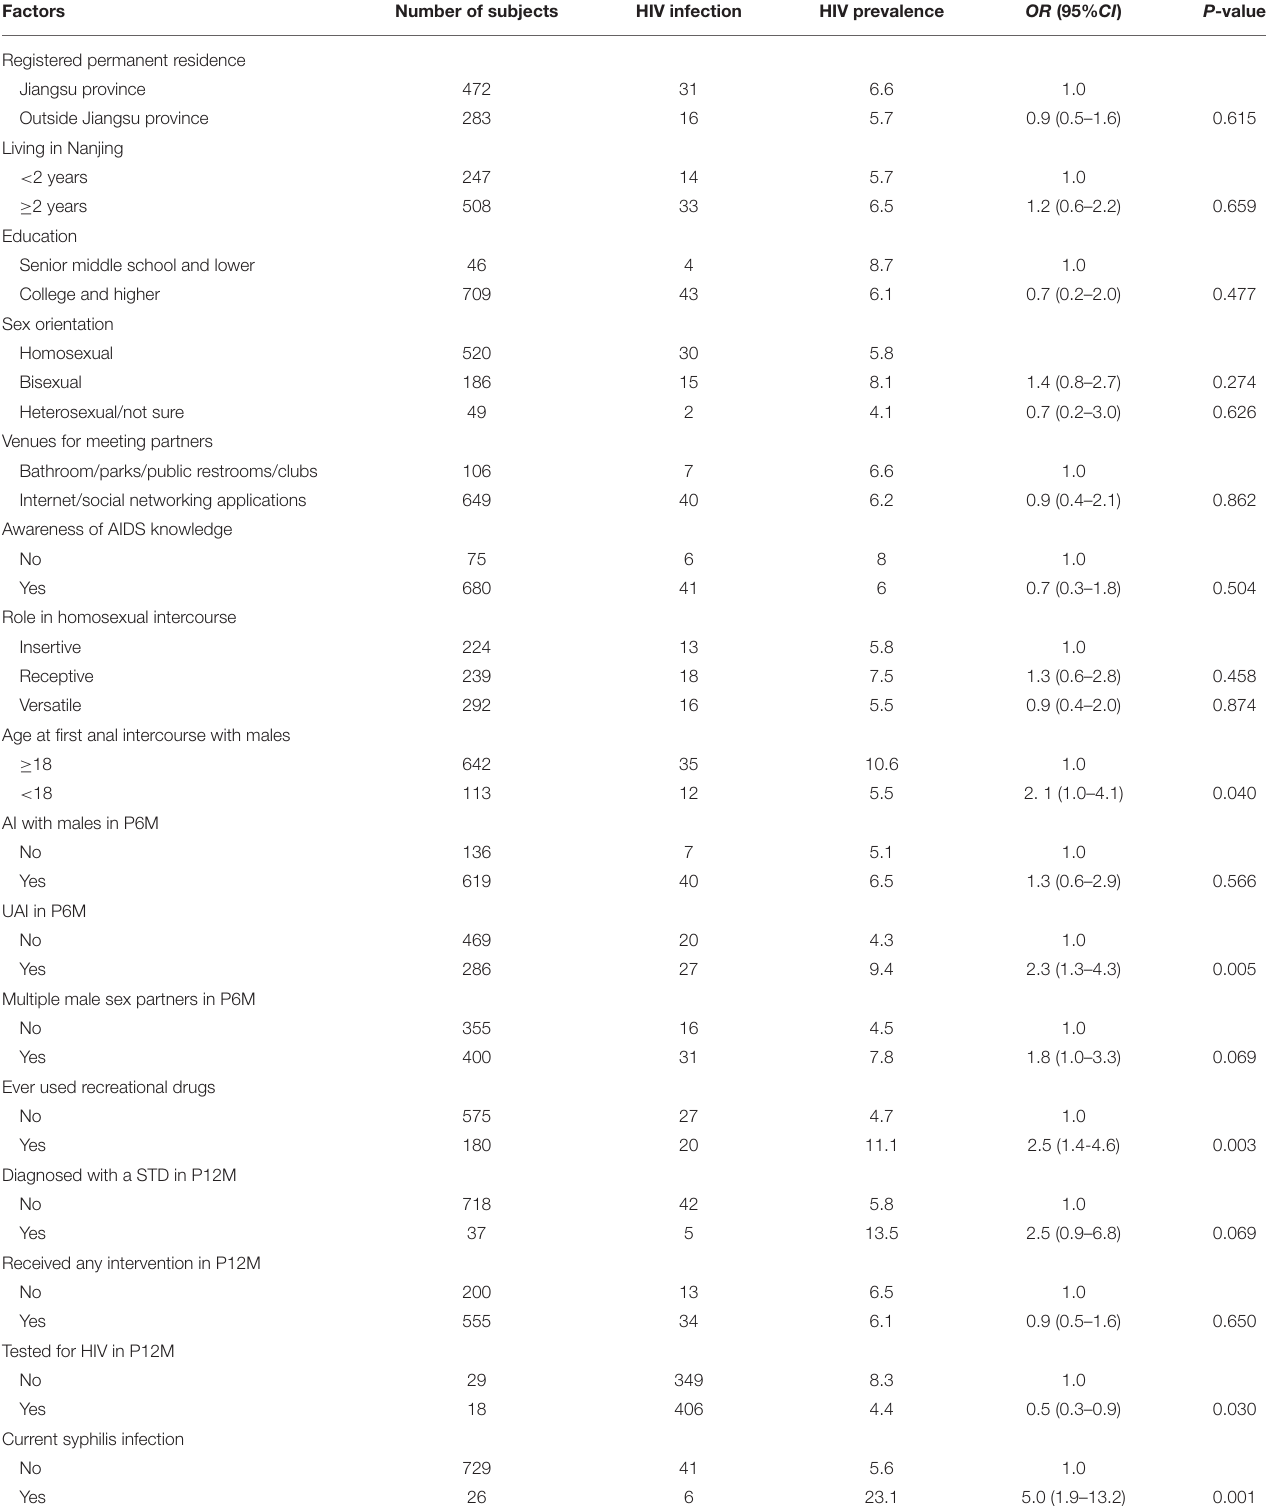
TABLE 3 | Factors associated with HIV infection by univariate logistic regression analyses among SMSM in Nanjing, China.